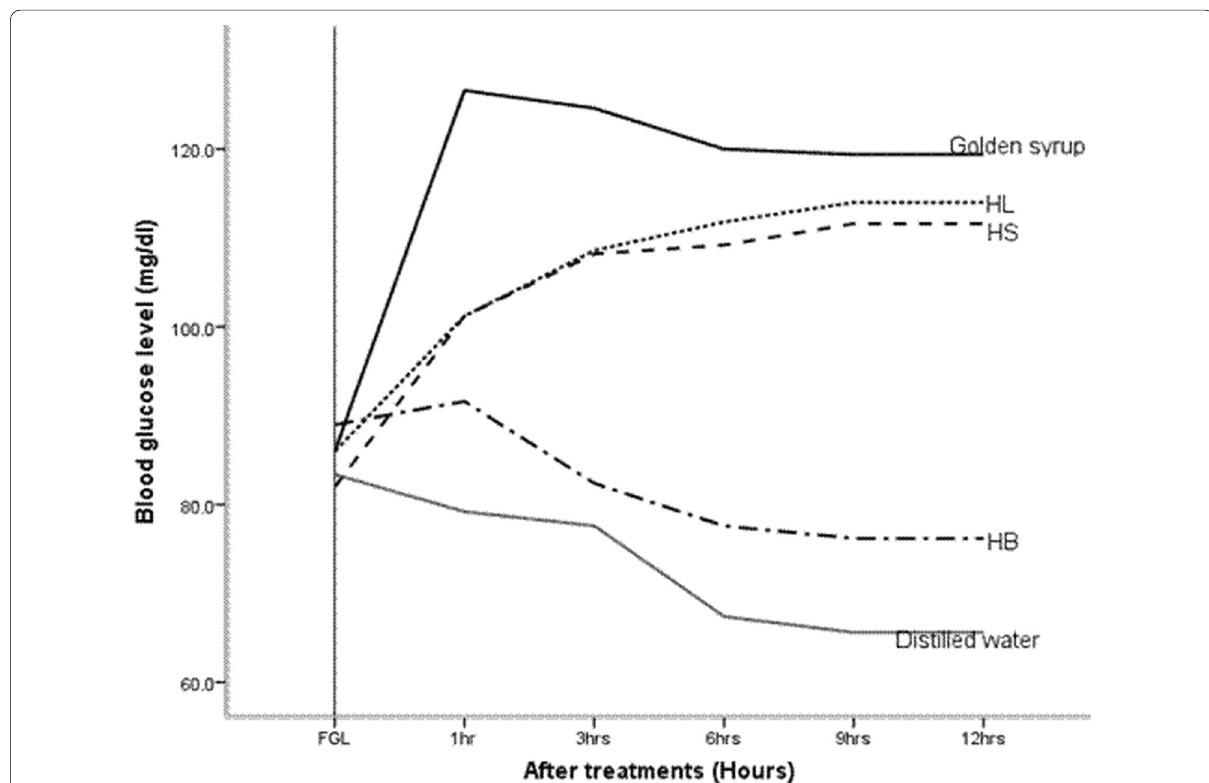
Fig. 1 Changes in blood glucose level in mice treated with selected samples of honeys from different sources. HB: Honey from beekeepers with none adulterated. HS: Honey from supermarkets with some adulterated. HL: Honey from local parkers with some adulterated and